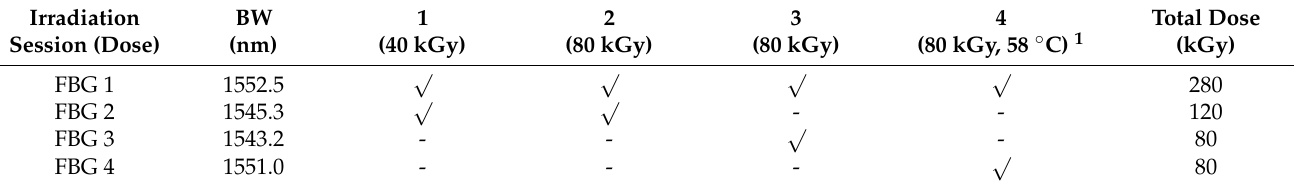
Table 1. Order of the irradiation sessions with corresponding doses and FBGs.